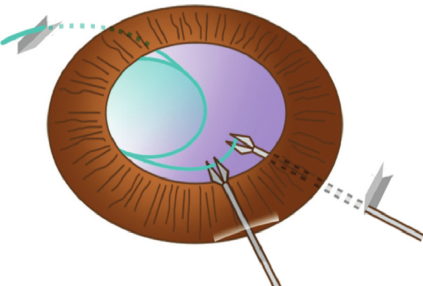
Figure 3: Diagram of the trailing haptic grasped by 27G forceps.